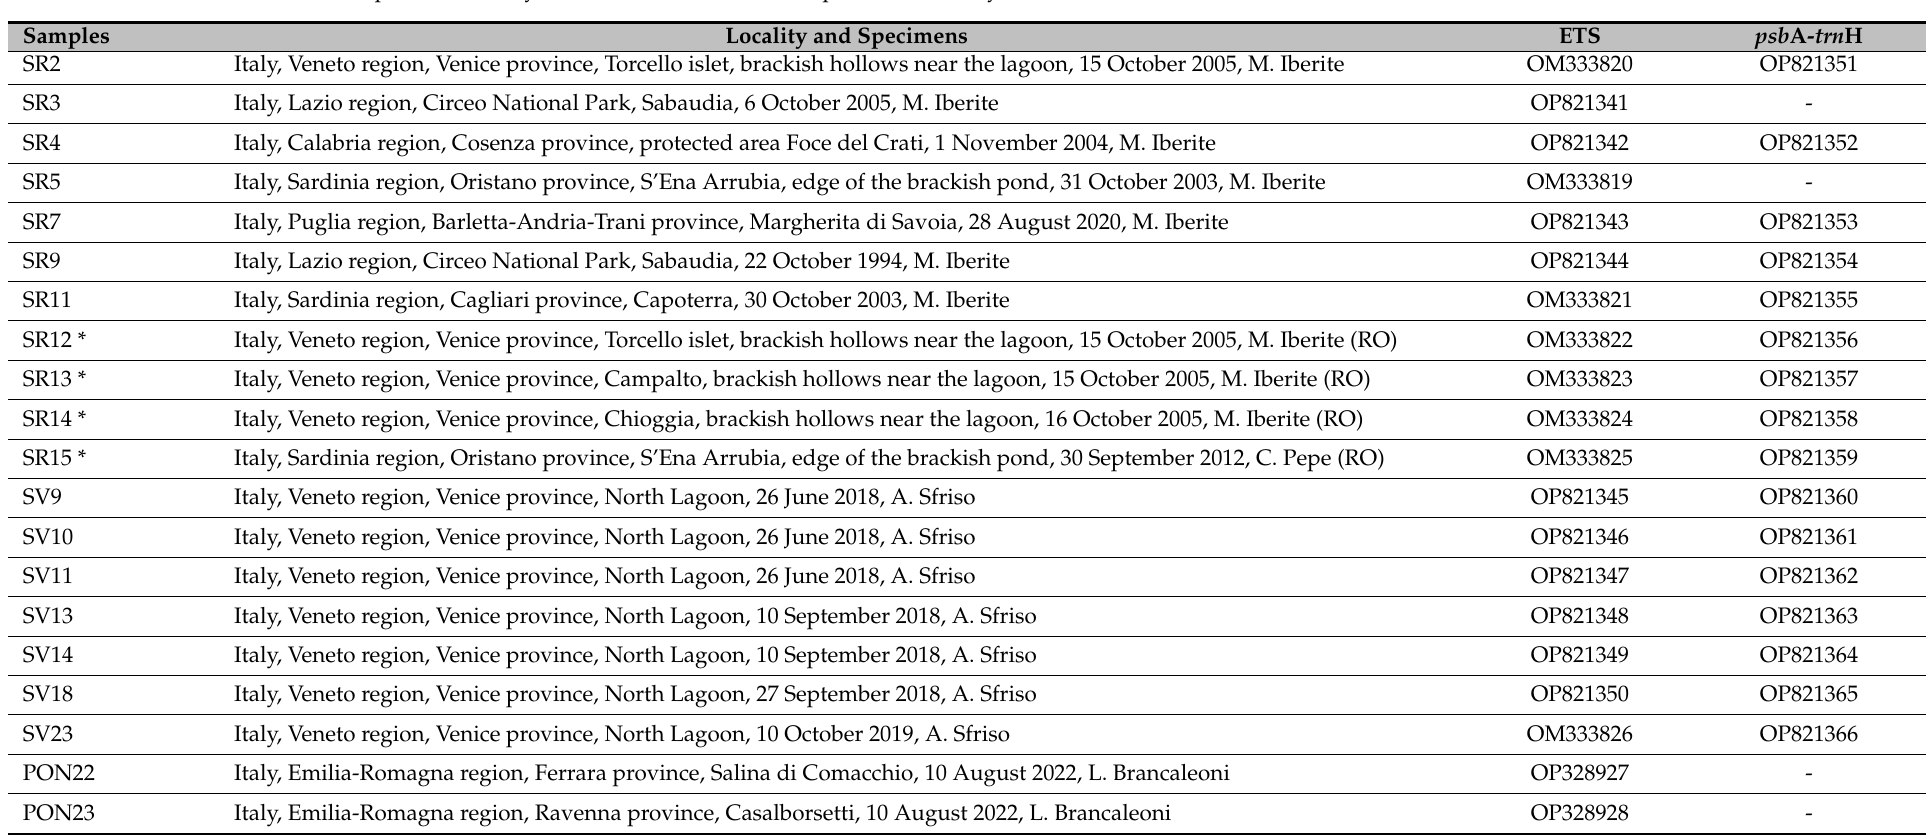
Table 1. Italian Salicornia populations considered in the present study. For each sample, the identification code, the sampling site, and the accession numbers of the sequenced molecular markers are reported (a dash indicates that the sequence was not obtained). Asterisks (first column) indicate the populations used for morphometric analyses; RO: Herbarium of the Sapienza University of